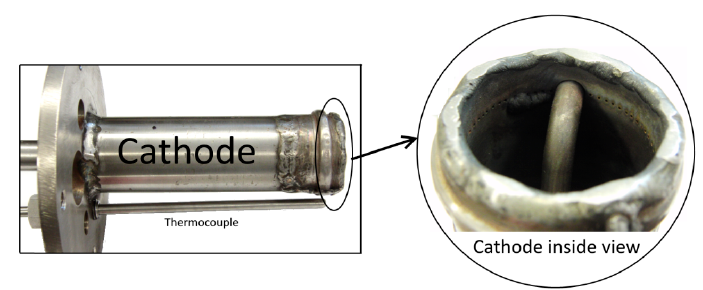
Figure 6. View of the Model III cathode construction before the lithiation process.